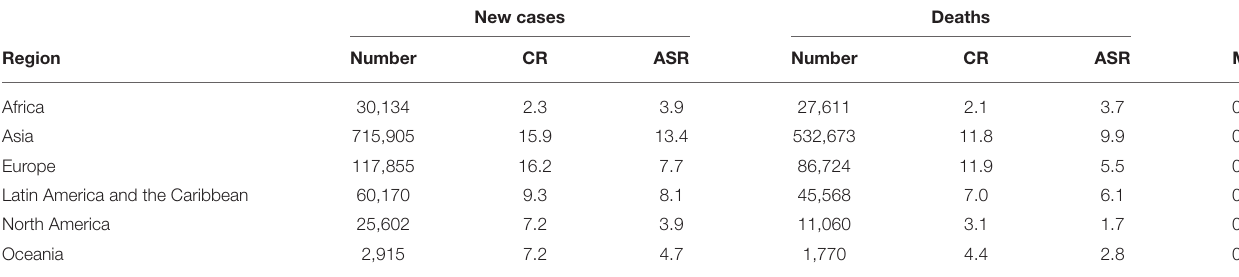
TABLE 1 | Summary of the number, crude rank, age-standardized rate, and mortality-to-incidence ratio of gastric cancer according to the regions. New cases Deaths Region Number CR ASR Number CR ASR